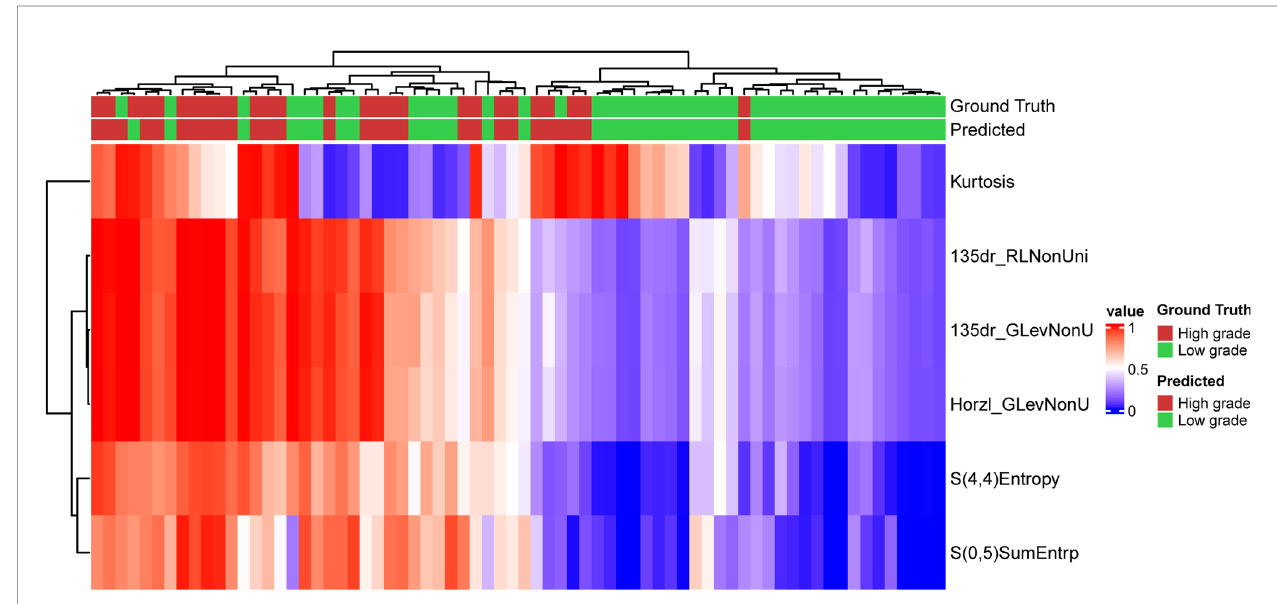
FIGURE 1 | Prediction result and the heatmap of the selected 6 features in the training set along the clustering results of the samples and the features.